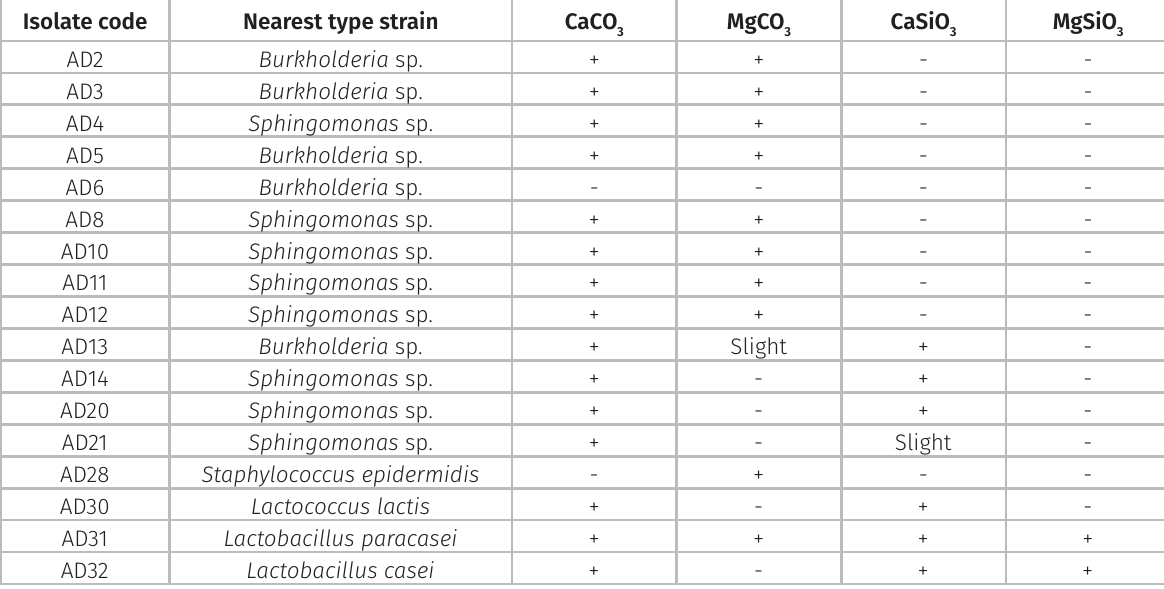
Figure 1. Carbonate and Silicate dissolving potential of the isolates. a: CaCO , b: MgCO c: CaSiO 3 3 3 d: MgSiO containing 3